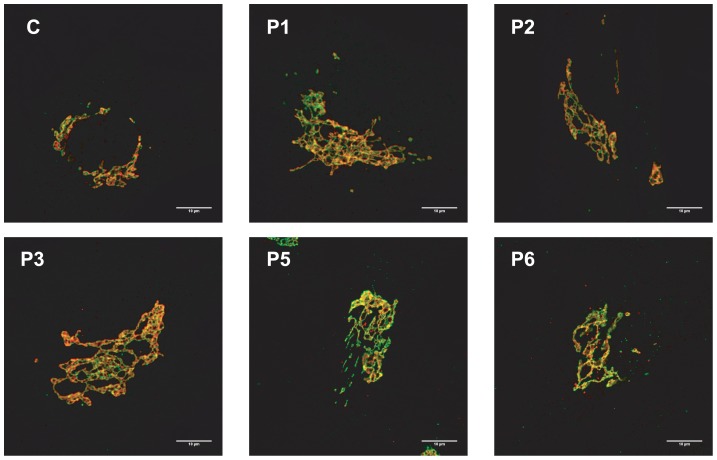
MAN1B1-deficient fibroblasts present alterations in Golgi structure.Golgi localization of GM130 (red) and TGN46 (green) in control and MAN1B1-deficient fibroblasts. Cells were fixed, double-labelled with antibodies against GM130 and TGN46, and analysed by confocal laser scanning microscopy. Scale bar represents 10 µm.